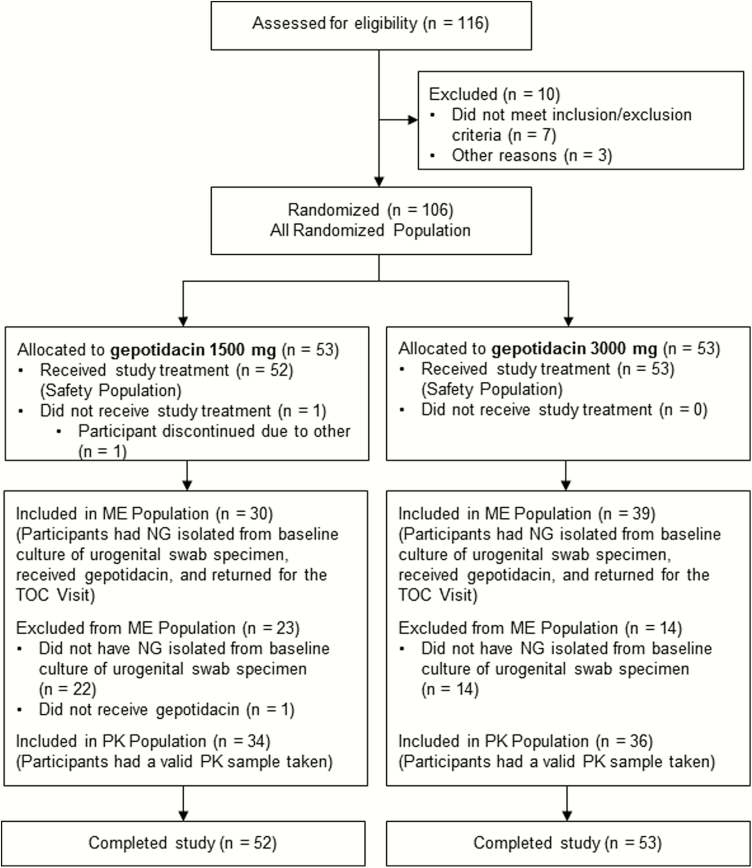
Participant disposition flow diagram. Abbreviations: ME, microbiologically evaluable; NG, Neisseria gonorrhoeae; PK, pharmacokinetic; TOC, test-of-cure.